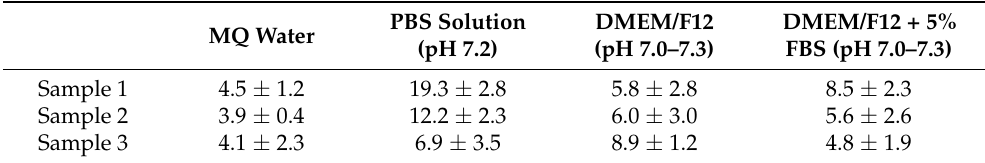
Table 1. Hydrodynamic radii of the particles in the gadolinium-doped ceria sols in different media, as measured using dynamic light scattering. The results are presented as mean ±